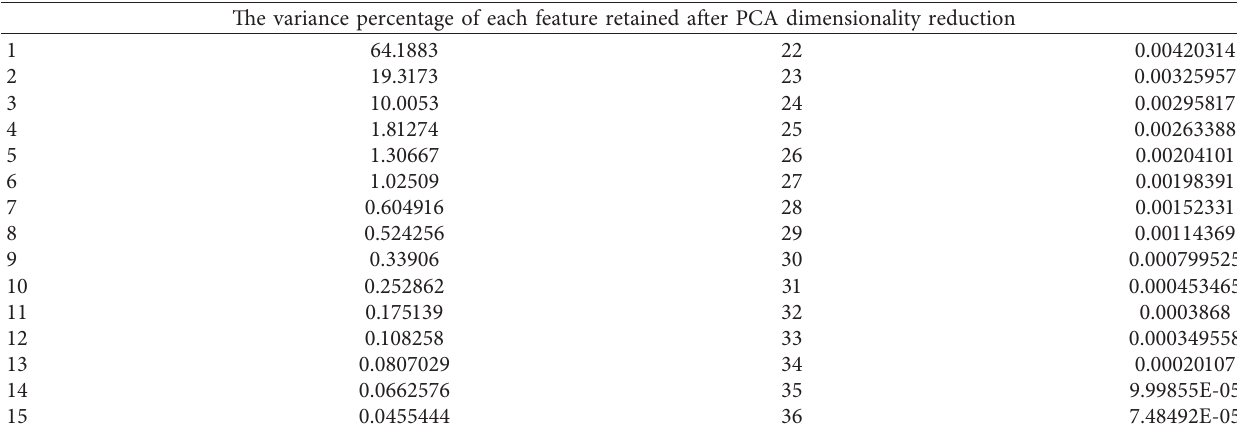
Table 3: The variance percentage of each feature retained after PCA dimensionality